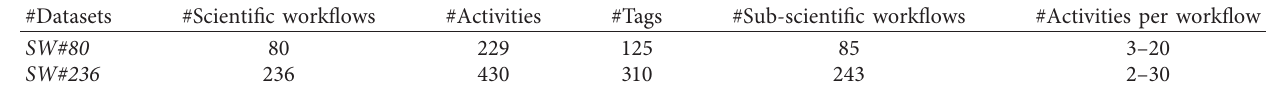
Table 2: Statistics of